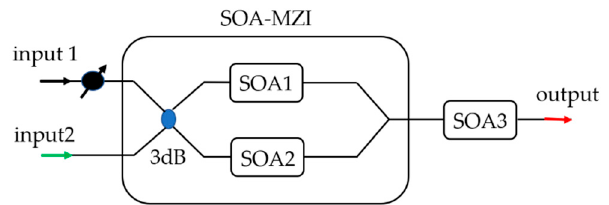
Figure 9. SOA-based implementation of the nonlinear function. SOA is placed in the two arms of MZI, which mainly performs phase modulation. The input signal and the reference signal go through the 3dB coupler, then are input into the two SOA for phase modulation. Cross-modulation is completed in SOA3.